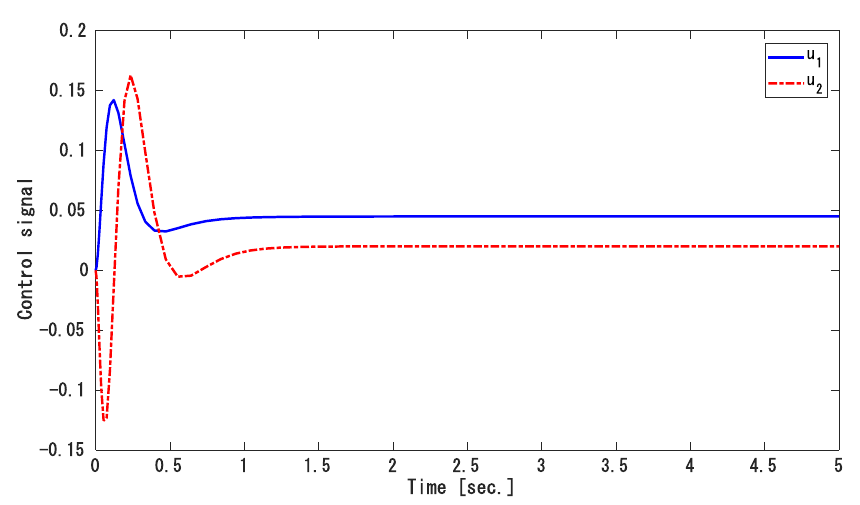
Figure 4. Control signal.